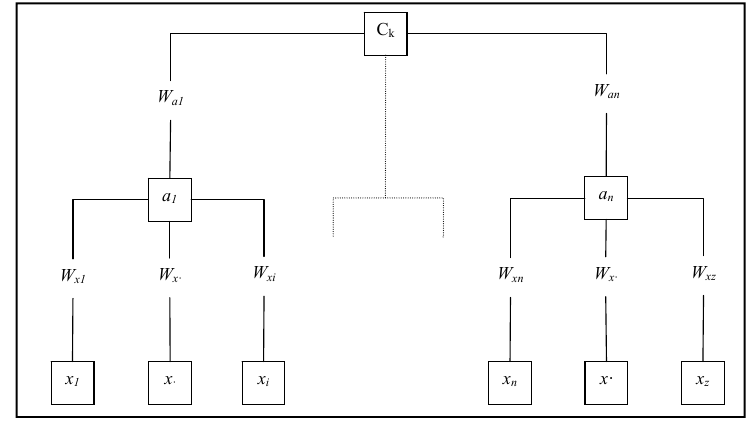
Figure 1. The hierarchical structure of the model.